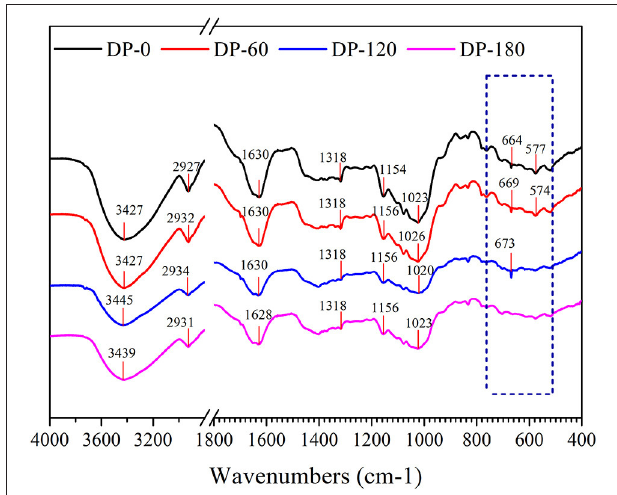
FIGURE 5 | The FTIR spectra (4,000–400 cm − 1 ) of RPA in the DP-0, DP-60, DP-120, and DP-180